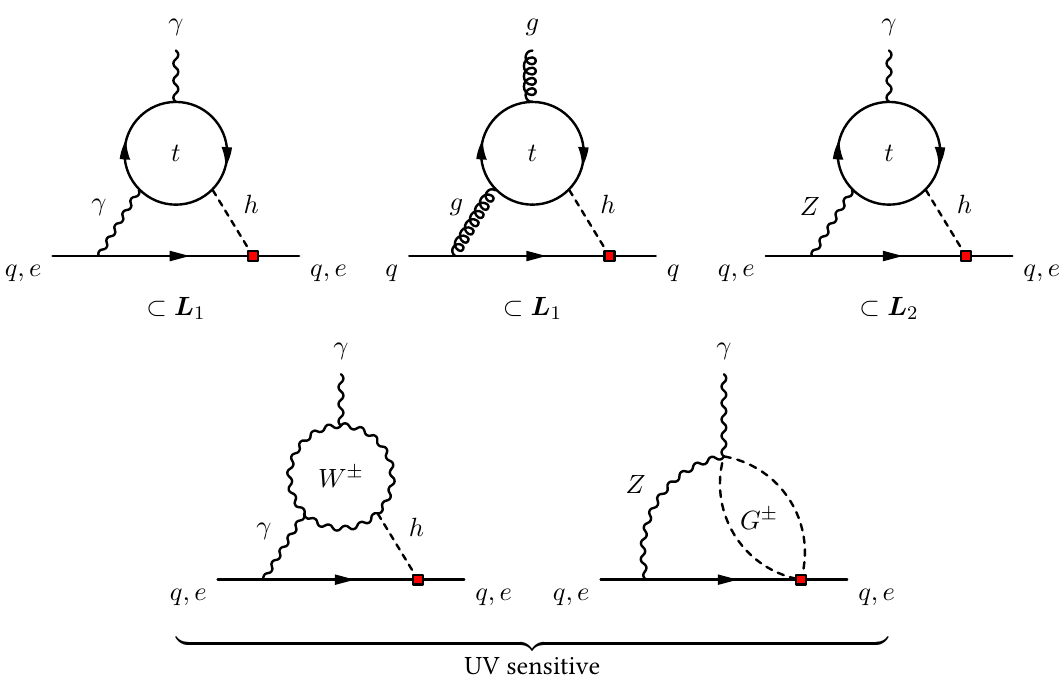
Figure 2 . Representative Barr-Zee-type Feynman diagrams contributing to the two-loop matching of dipole operators at the electroweak scale. The label under the diagrams indicates the loop function ( L 1 and L 2 ) to which the corresponding diagram contributes. The red square vertex indicates a CP-violating Higgs Yukawa, C fH − . Electroweak diagrams like those in the second row are responsible for the UV sensitivity of contributions proportional to C eH − and C qH − for the electron and light-quark EDM operators, respectively. Diagrams with dimension-five couplings (lower right) are required to obtain a gauge-invariant result. See main text for